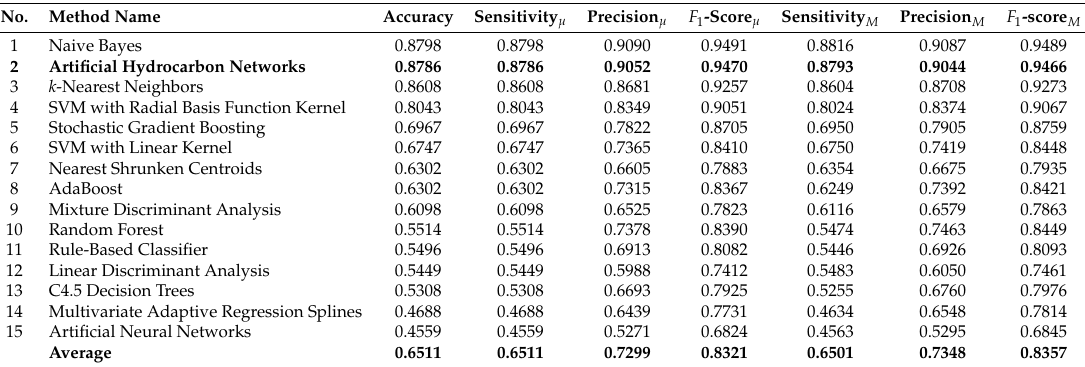
Table 10. Comparison of the supervised classifiers using the 30% noisy dataset of the case